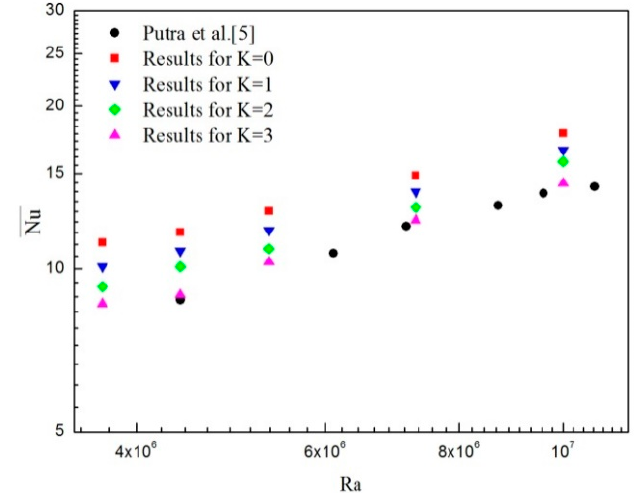
Figure 3. Comparison of the average Nusselt number with experimental results of Putra et al. [5] versus Rayleigh number with increasing vortex viscosity parameter K for φ = 4%.